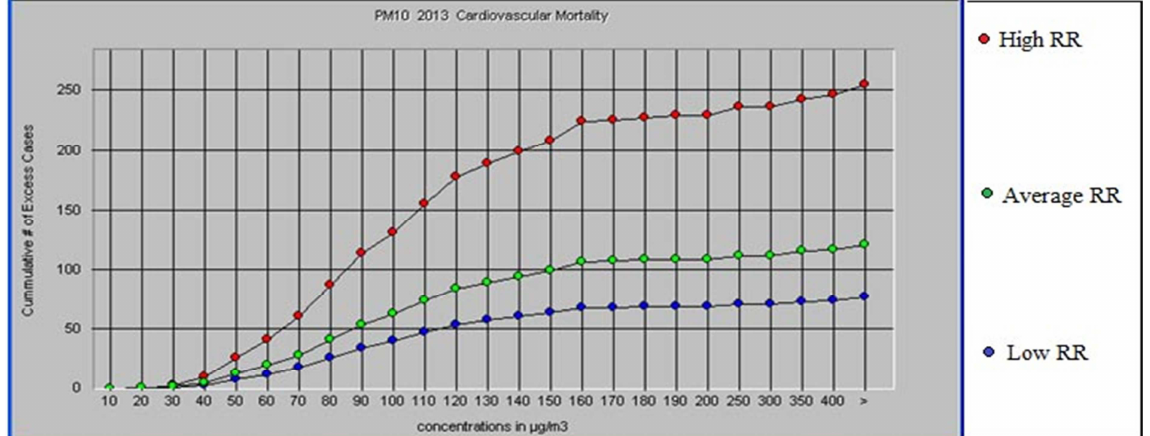
Figure 6. Estimated cumulative number of cardiovascular mortality cases attributable to particulate matter with aerodynamic diameters <10 µm comparing concentration intervals (Sanandaj, Iran, 2013) RR: Relative risk